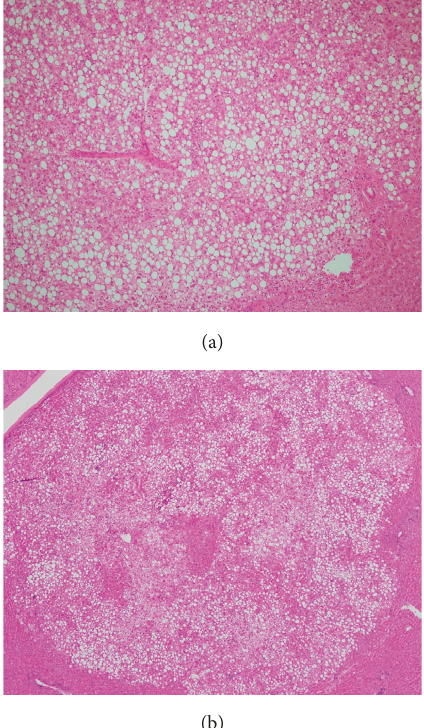
Figure 4: (a) Histologic findings of ectopic hepatocellular adenoma attached to the gallbladder serosa (H&E, × 100). (b) Steatotic microadenoma in the mother liver (H&E, ×